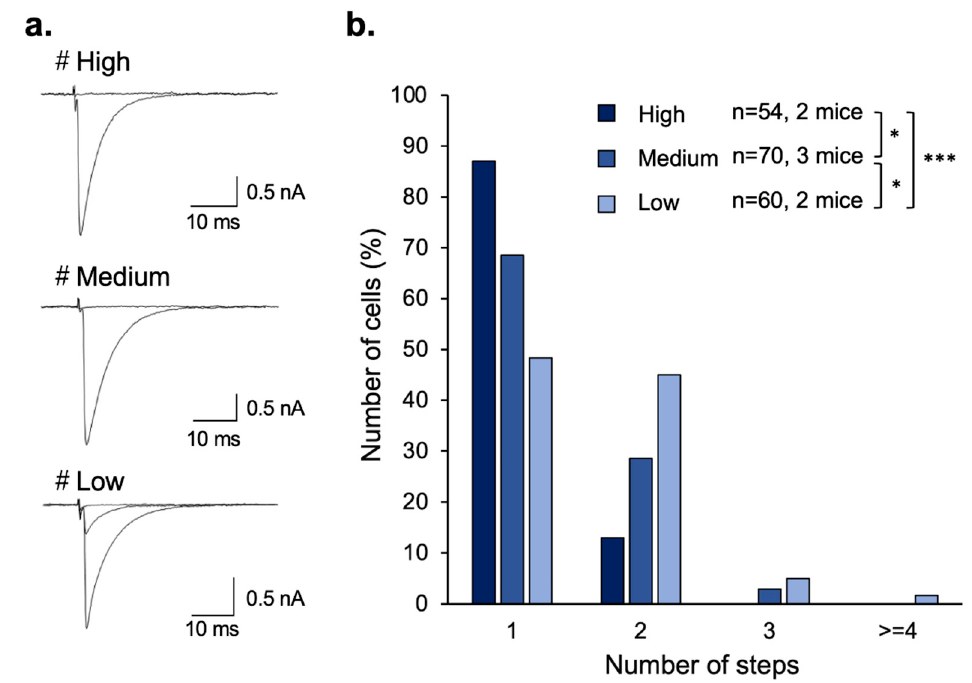
Figure 3. Sample records ( a ) and summary graphs ( b ) of CF-EPSCs from adult mGluR5-rescue PCs. Summary graphs show frequency distributions of PCs in terms of the number of discrete steps of CF-EPSCs from mGluR5-rescue High (n = 54 from 2 mice), Medium (n = 70 from 3 mice), and Low (n = 60 from 2 mice) mice. * p < 0.05, *** p < 0.005.